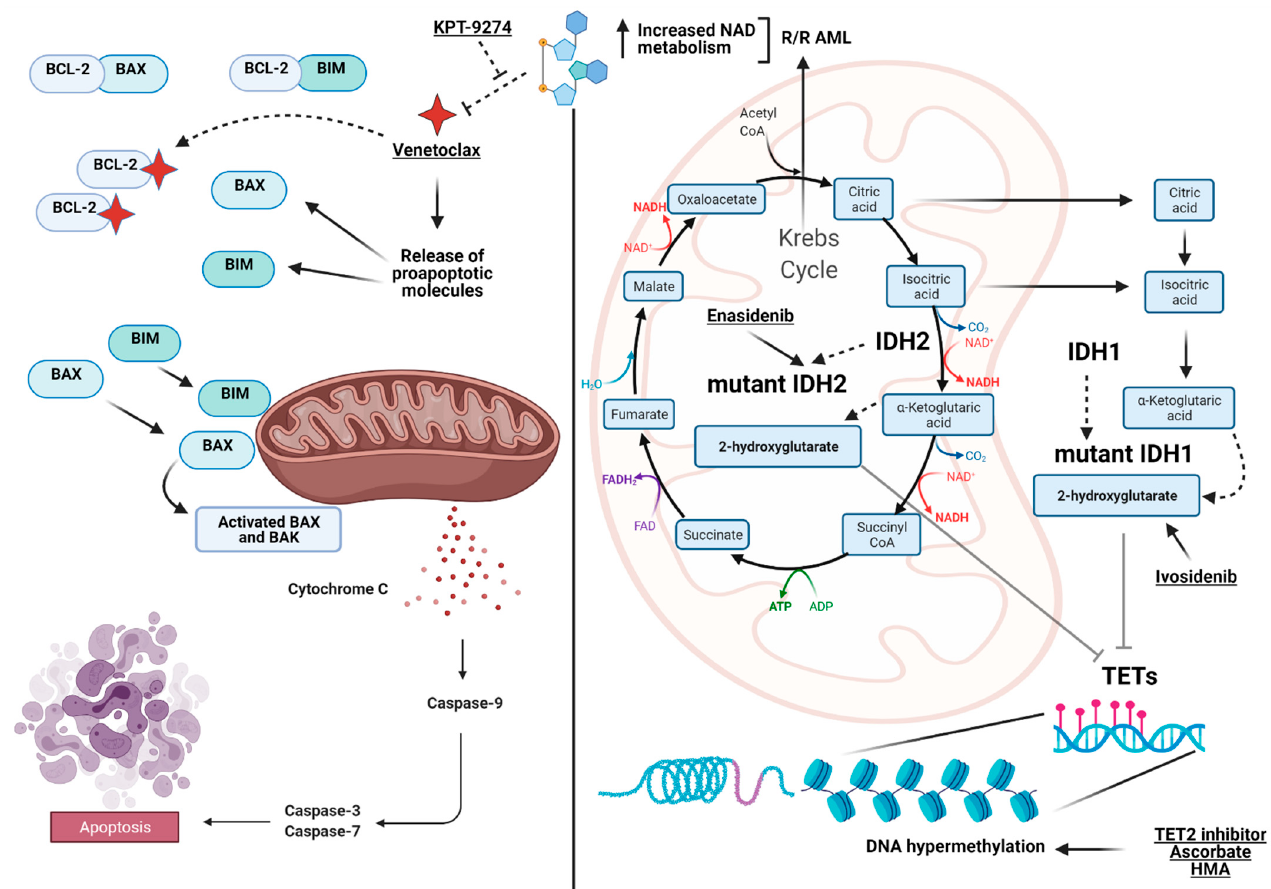
Figure 1. View at a glance of the landscape of the metabolic interactions between genes and pathways discussed in the manuscript. On the left, the intrinsic apoptotic pathway highlighted by BCL-2 as the pivotal player (targeted by Venetoclax) and the interaction with BAX and BIM to initiate the caspases cascade to trigger apoptosis. On the right, the interaction between the Krebs cycle (TCA), the convergence of IDH1/2 generating α -ketoglutarate, 2-hydroxyglutarate and the TET family of genes, which finally impacts DNA methylation. Included are also the available drugs used to target the depicted pathways. On the top, in relapsed/refractory (R/R) acute myeloid leukemia (AML), the interconnection between the increase in NAD metabolism generated by alteration of oxidative phosphorylation and Venetoclax resistance is shown together with proposed actionable target agents (e.g., KPT-9274) inhibiting Nicotinamide Phosphoribosyltransferase (NAMPT). Images were generated using BioRender.